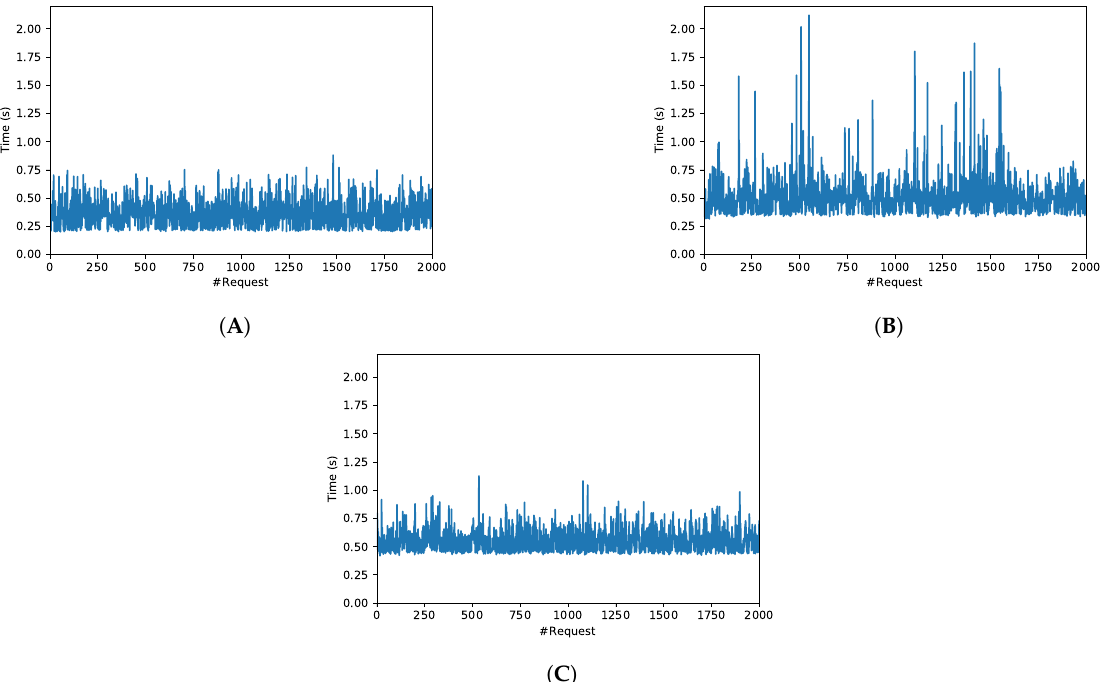
Figure 14. Response time in OrbitDB for ( A ) Scenario D, ( B ) Scenario E and ( C ) Scenario